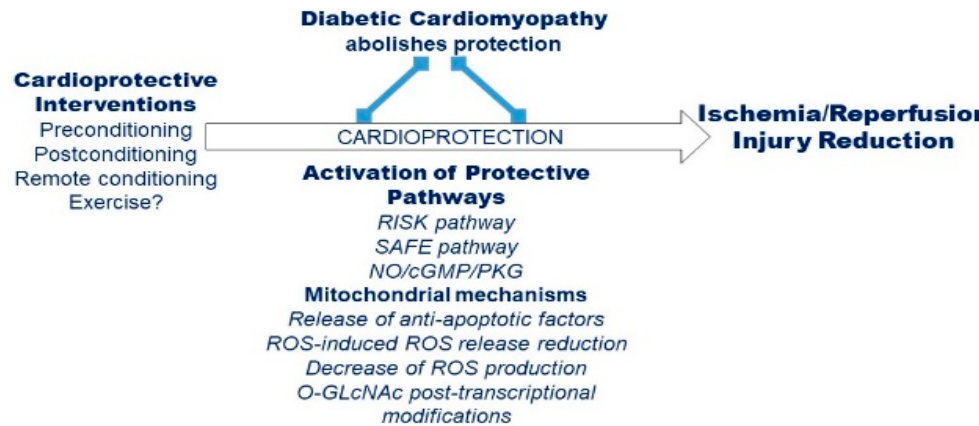
Figure 4. Overview of cardioprotective mechanisms and pathways altered / inhibited by diabetic condition.